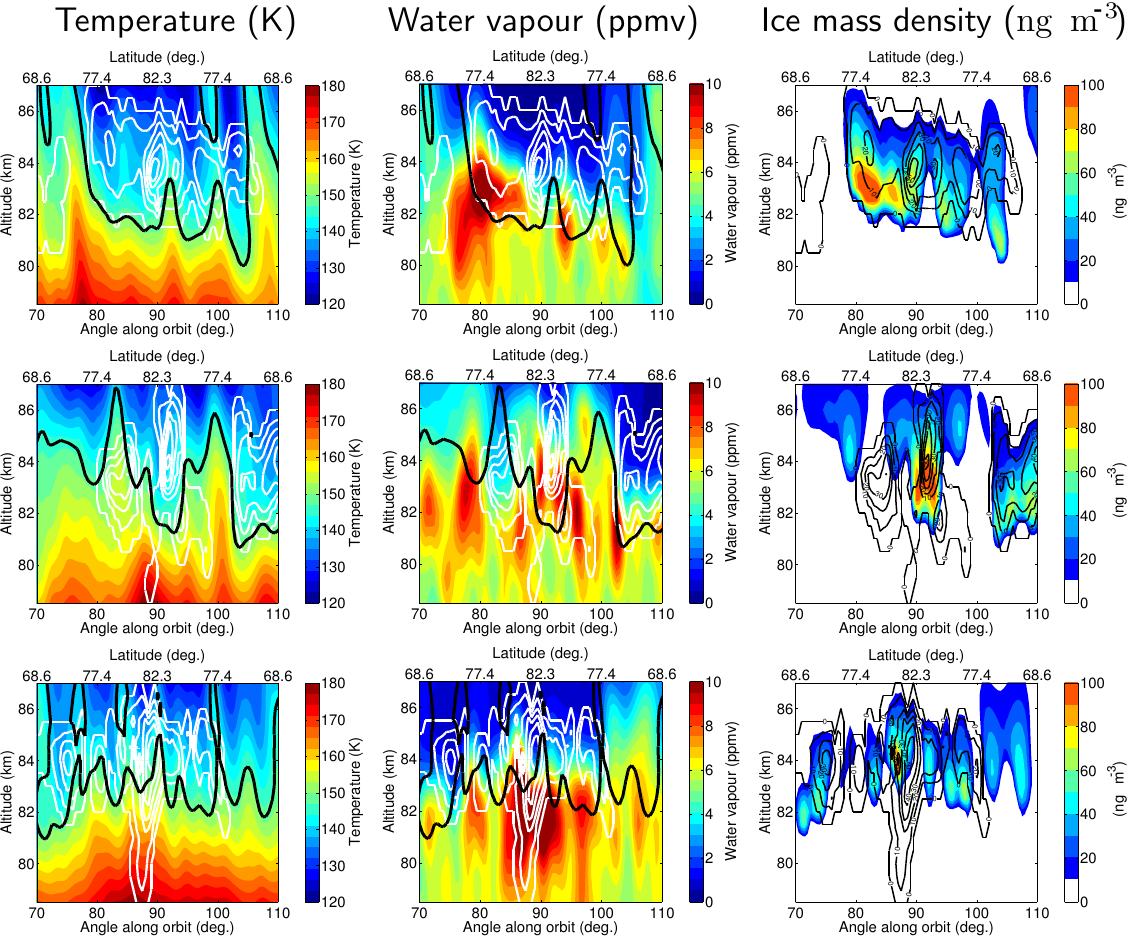
Figure 5. Three orbits measured during July 2010 (orbit 51226, top) and 2011 (orbit 56735, mid and orbit 56726, bottom). The left and centre panels show the temperature and water vapour concentration retrieved from SMR (coloured contours) together with the observed ice mass density (white contours, each contour line corresponds to 10ngm − 3 ). The black contour shows the area where S > 1. The rightmost plots show the ice mass density predicted by the equilibrium model (colours) and the ice mass density measured by OSIRIS (black contours, each contour line corresponds to 10ngm − 3